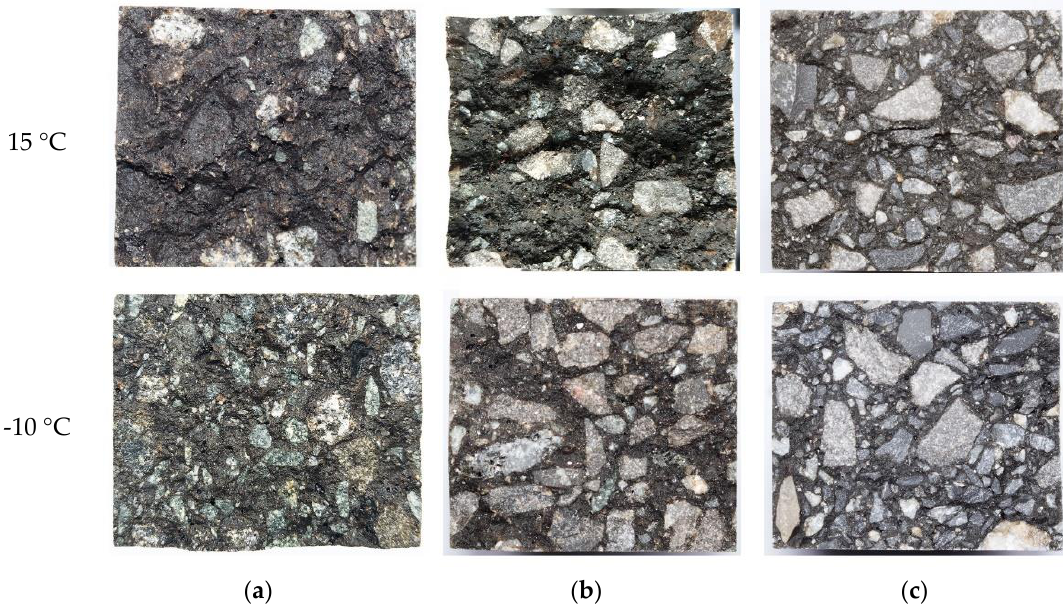
Figure 14 . Fracture sections of beams of EACs containing: ( a ) diabase, ( b ) granite, and ( c ) limestone.